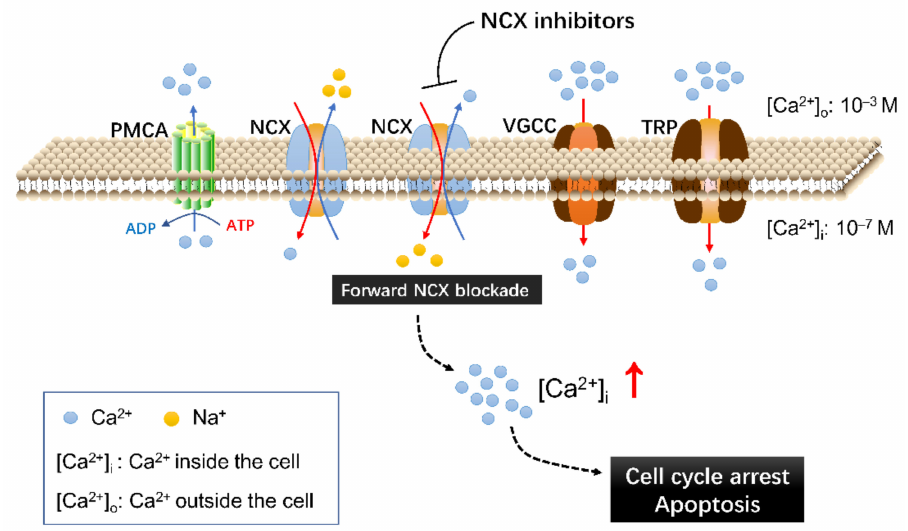
Figure 7. The action of NCX inhibitors on the Ca 2+ transport/signaling system of melanoma cells and relevant consequences. Blockade of Na + -dependent Ca 2+ efflux (forward NCX operation) by some NCX inhibitors occluded NCX-mediated Ca 2+ extrusion, while extracellular Ca 2+ still entered cells through VGCCs, TRP, and other Ca 2+ -permeable channels, resulting in Ca 2+ accumulation and Ca 2+ -dependent cell death. Ca 2+ : Calcium ions; PMCA, plasma membrane Ca 2+ -ATPase; NCX, Na + /Ca 2+ exchanger; VGCC: voltage-gated Ca 2+ channel; TRP, transient receptor potential channel; M,